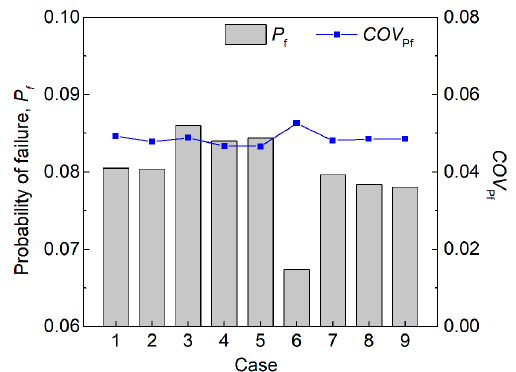
Figure 6. Probability of failure for different cases.